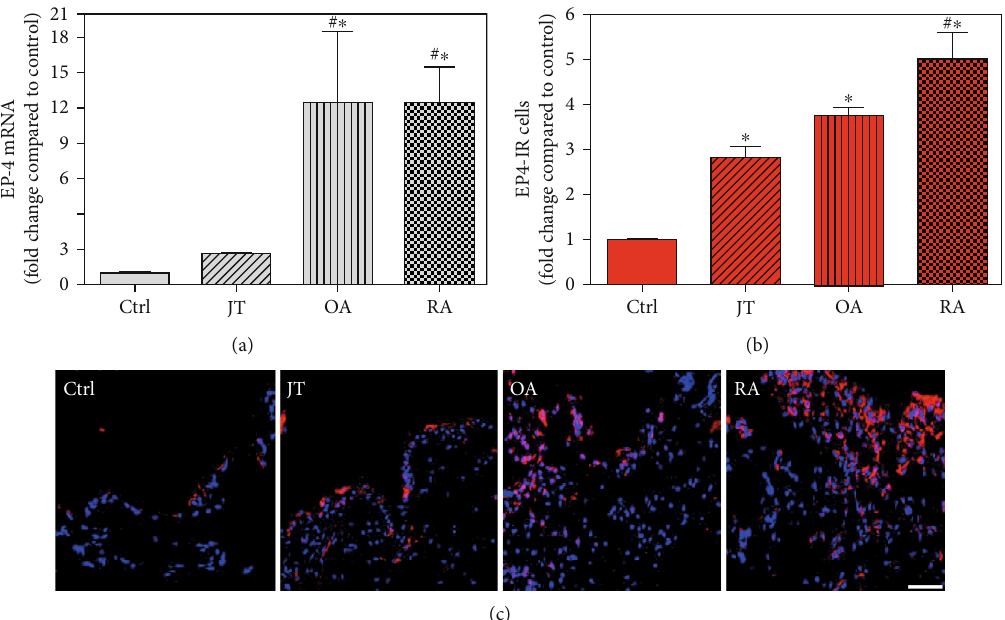
Figure 7: Detection of PGE-2 receptor 4 (EP4 receptor) mRNA (a) and number of EP3-IR cells (b, c) in patients with joint trauma (JT), osteoarthritis (OA), and rheumatoid arthritis (RA). (a) Quanti fi cation of EP4 mRNA shows that EP4 mRNA was signi fi cantly higher in rheumatoid and osteoarthritic synovium compared to JT and control (data are shown as means ± SEM , P < 0 : 05 , one-way ANOVA followed by Tukey ’ s test). (b) Quantitative analysis of immuno fl uorescence microscopy for EP3-IR cells relative to the control synovium (data are shown as means ± SEM , P < 0 : 05 , Kruskal – Wallis ANOVA on ranks followed by Dunn ’ s test). (c) Immuno fl uorescence microscopy shows more abundant EP3-IR cells (Texas red fl uorescence) in JT, OR, and RA compared to control synovium. DAPI blue fl uorescence shows nuclear staining. Bar = 20 μ m . ( ∗ P < 0 : 05 , compared to control, # P < 0 : 05 , compared to